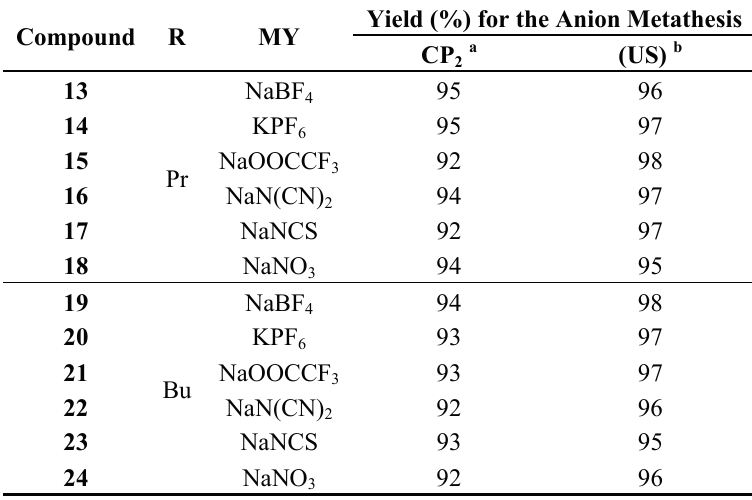
Table 2. Reaction conditions and yields for the anion metathesis reaction using conventional preparation (CP) and ultrasound irradiation conditions